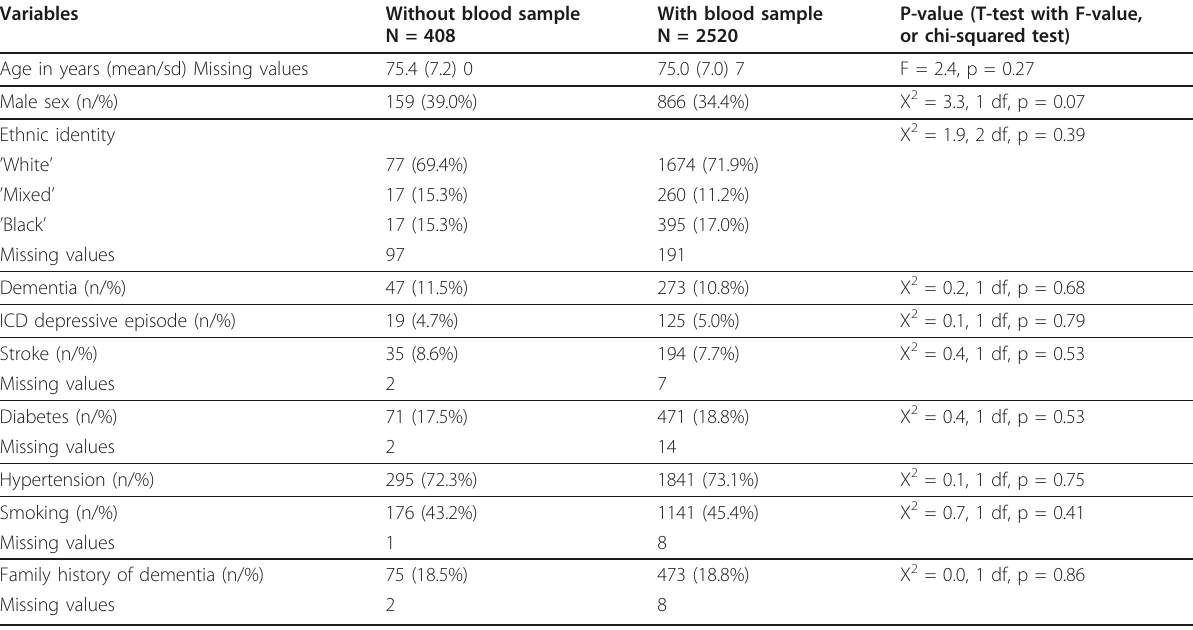
Table 1 Sample characteristics, by availability of blood sample Variables Without blood sample